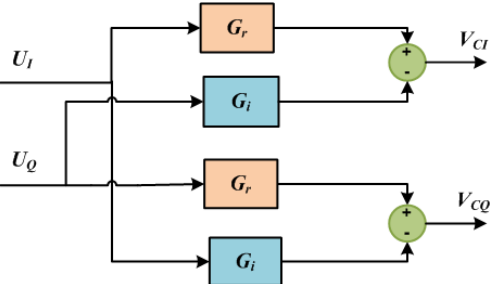
Figure 3. Cavity’s voltage I and Q components and their coupled transfer functions.